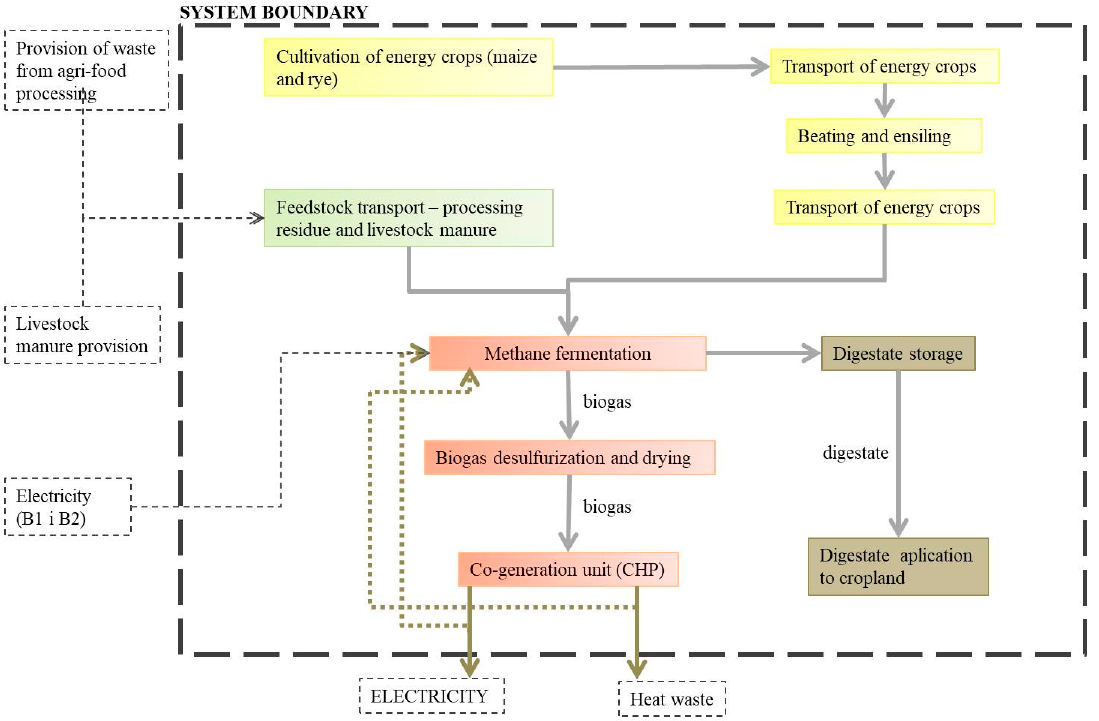
Figure 1. System boundary of the electricity production from agricultural biogas in the examined agricultural biogas plants [11].